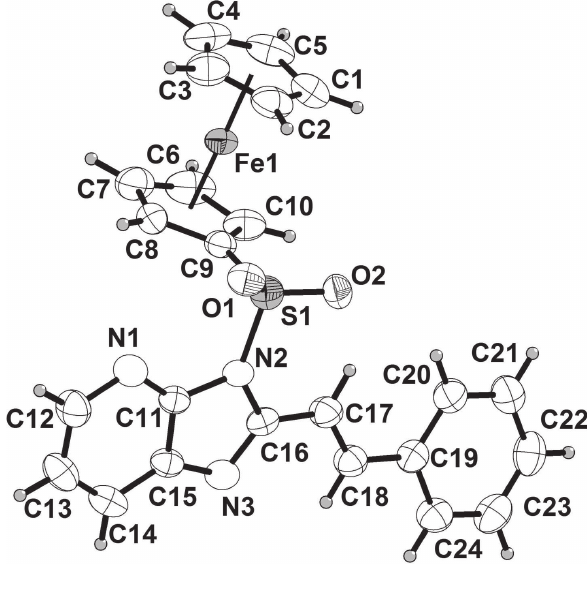
Table 1: Data collection and handling.